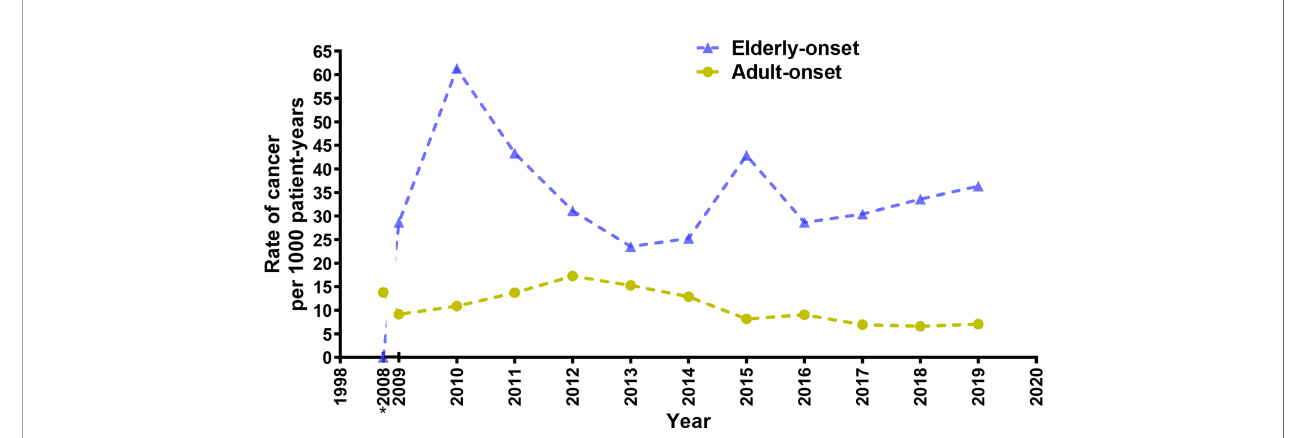
FIGURE 2 | Annual incidence rate of cancer for elderly-onset IBD and adult-onset IBD as a function of calendar time presented as 3-year moving averages from 2009 to 2019. *Accumulated incidence rate of cancer from 1998 to 2008.